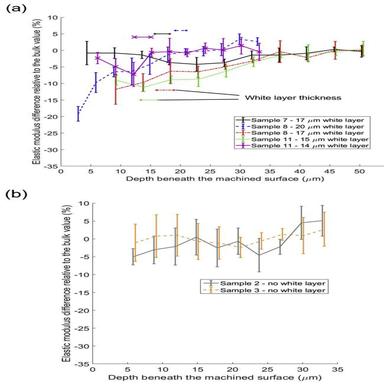
–Calculated elastic modulus (relative to the bulk value), with depth in the cross-section: (a) samples with a white layer and (b) samples without a white layer.